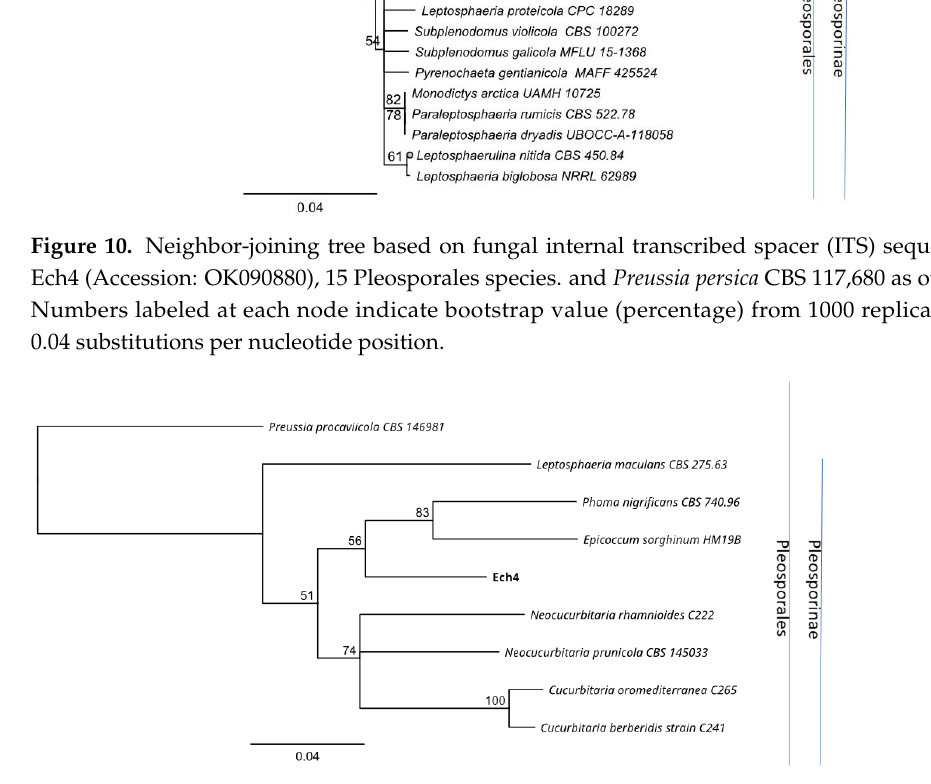
Figure 11. Neighbor-joining tree based on fungal tubulin sequences of Ech4 (Accession: OK319032), 8 Pleosporales species and Preussia procaviicola CBS 146,981 as outgroup. Numbers labeled at each node indicate bootstrap value (percentages) from 1000 replicates. Bar, 0.04 substitutions per nucleotide position.